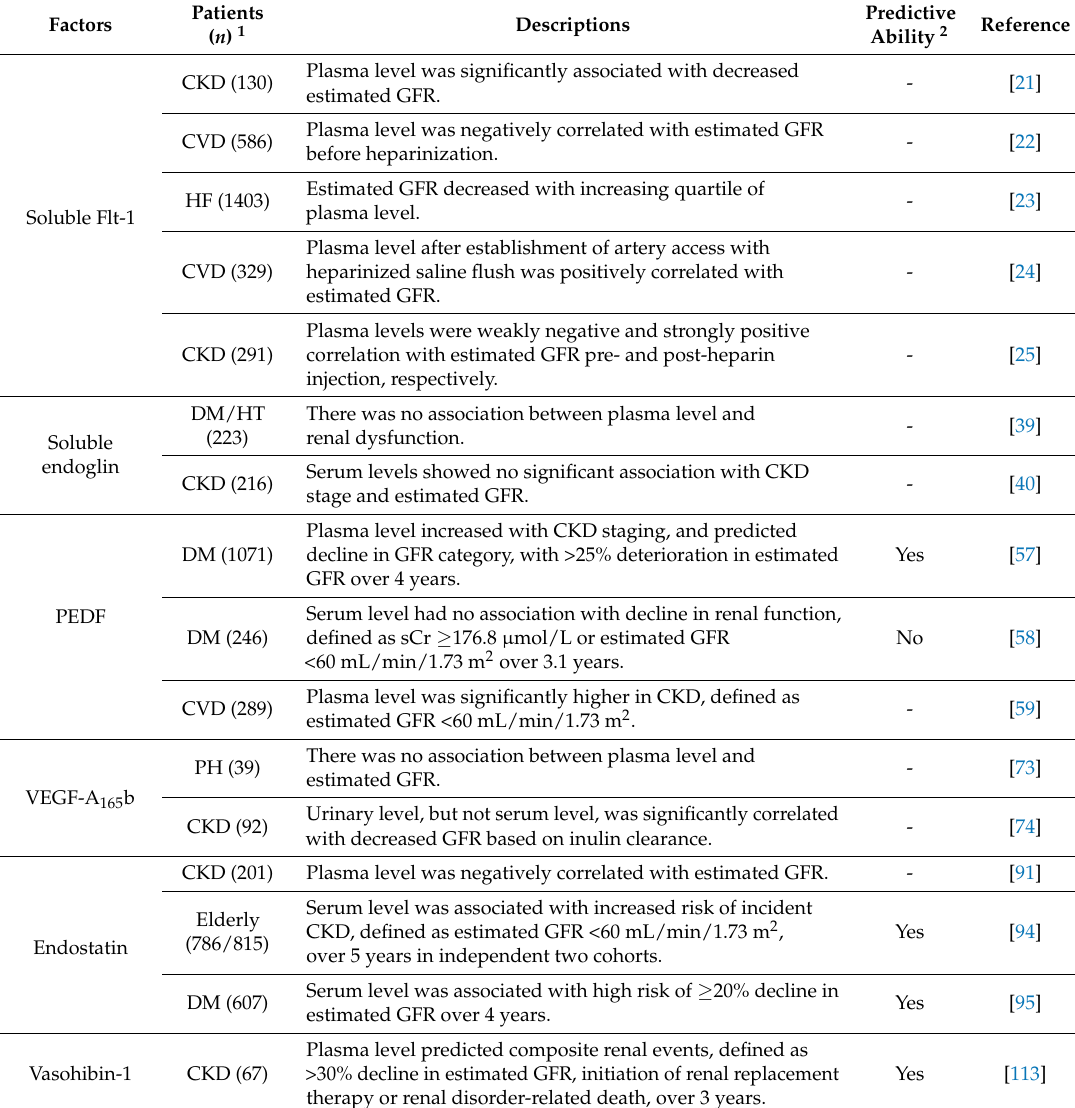
Table 1. Summary of clinical studies investigating the associations between circulating or urinary levels of antiangiogenic factors and renal